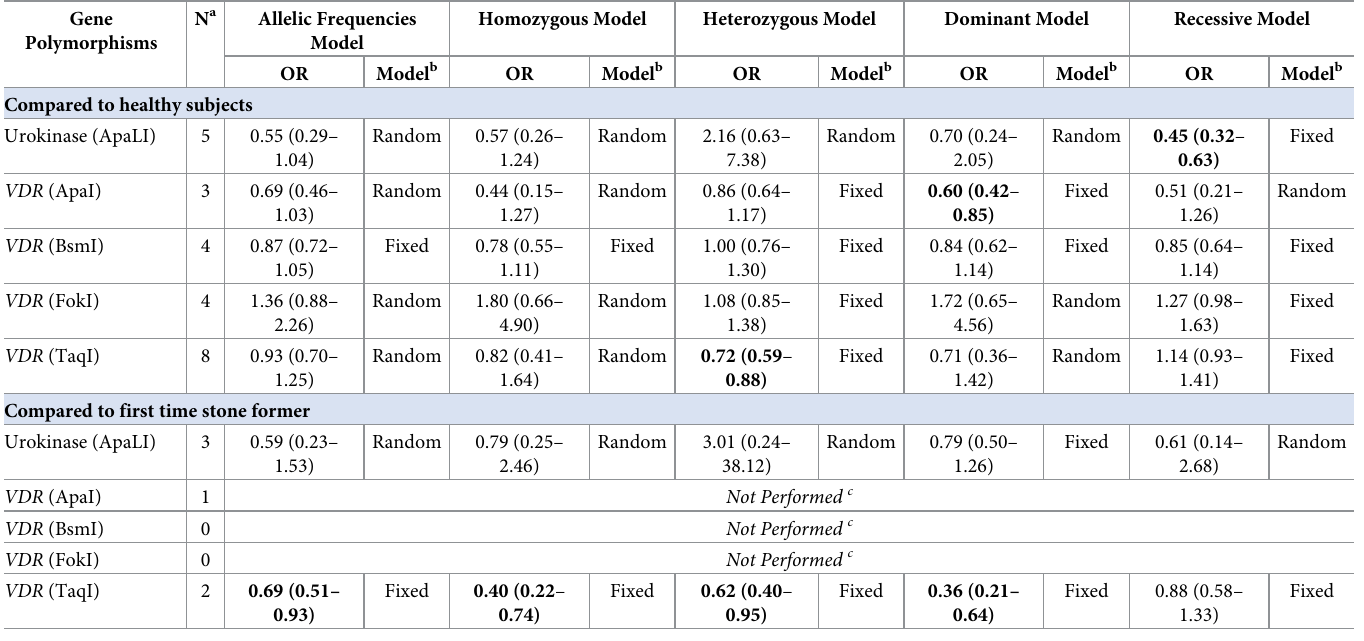
Table 4. Pooled OR analysis between the urokinase (ApaLI) and VDR (ApaI, BsmI, FokI, and TaqI) gene polymorphisms and recurrent kidney